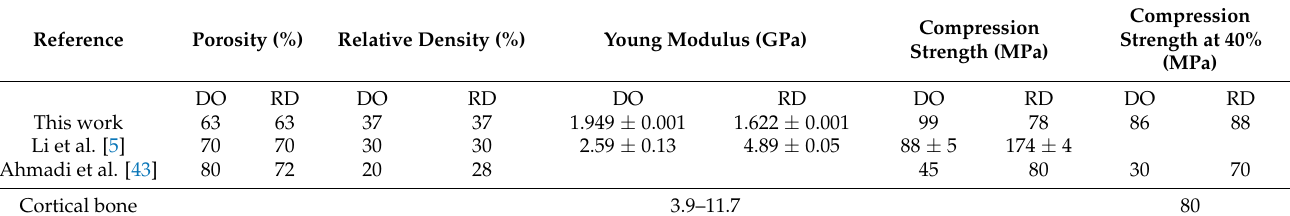
Table 7. Experimental results obtained from the compression tests compared to the results obtained by Li et al. [5] and Ahmadi et al. [43] with the same scaffold geometries, and reference values for cortical bone. Reference